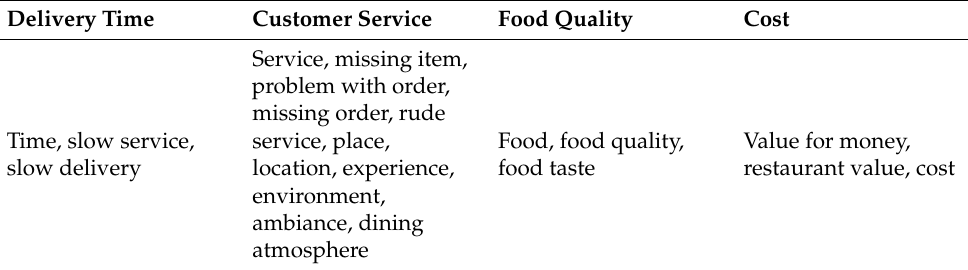
Table 4. FDS common complaint